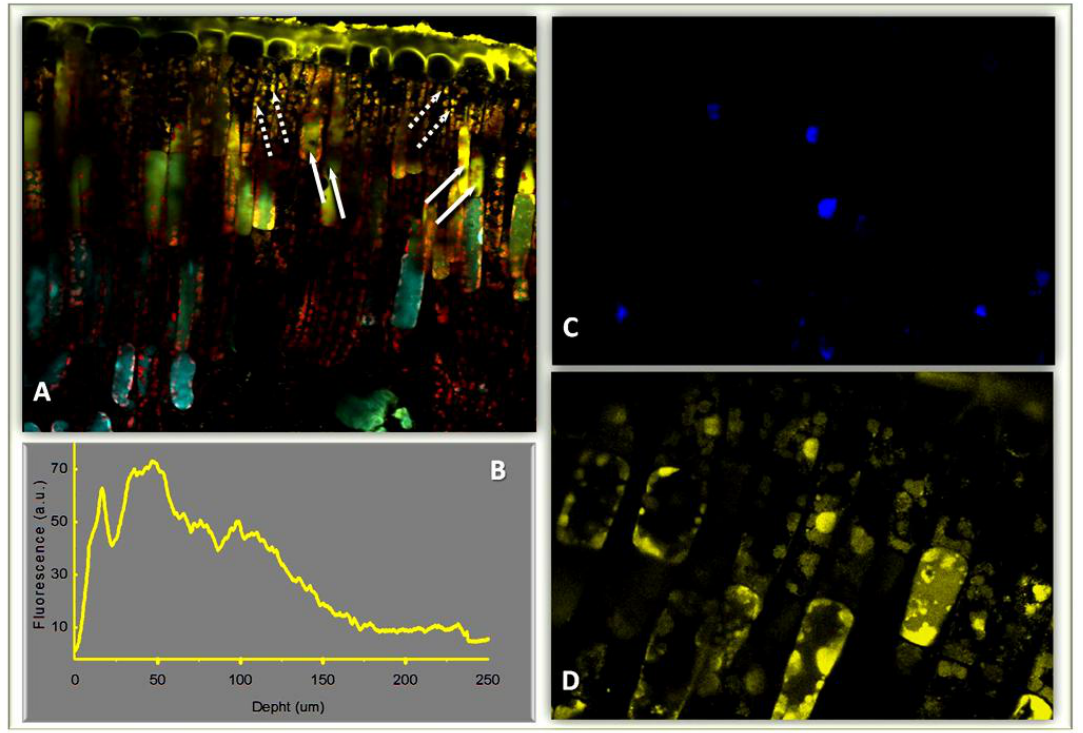
Figure 2. Inter and intracellular distribution of dihydroxy-B-ring-substituted flavonoid glycosides in leaves of L. vulgare leaves acclimated to full sunlight irradiance. Cross sections were stained with Naturstoff reagent and fluorescence images recorded in a Confocal Laser Scanning Microscope flowing the protocols of [10]. In brief, specimens were excited at 488 nm and fluorescence recorded at 580 ± 10 nm: this excitation-emission set-up has been previously reported to exclusively visualize flavonoids, in particular flavonoids with a catechol group in the B-ring of the flavonoid skeleton [10]. Dihydroxy flavonoids accumulate mostly in the adaxial tissue (up to a distance of 150–170 µm from adaxial surface, as revealed by profiles of their fluorescence acquired at 580 nm, reported in ( B ). Dotted and solid white arrows in ( A ) indicate flavonoids in the chloroplast and the vacuole, respectively. Dihydroxy flavonoids are located in the nucleus of mesophyll cells. Nuclei were stained with both DAPI (to visualize the nucleus) and Naturstoff reagent and images were recorded in the blue-channel for detecting DAPI fluorescence ( C ) or the yellow-channel for detecting flavonoid fluorescence ( D